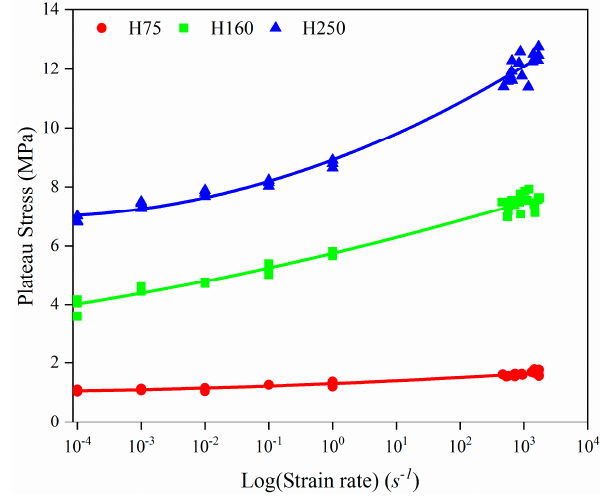
Figure 9. The plateau stress over the strain rate (log scale) for PVC foams.